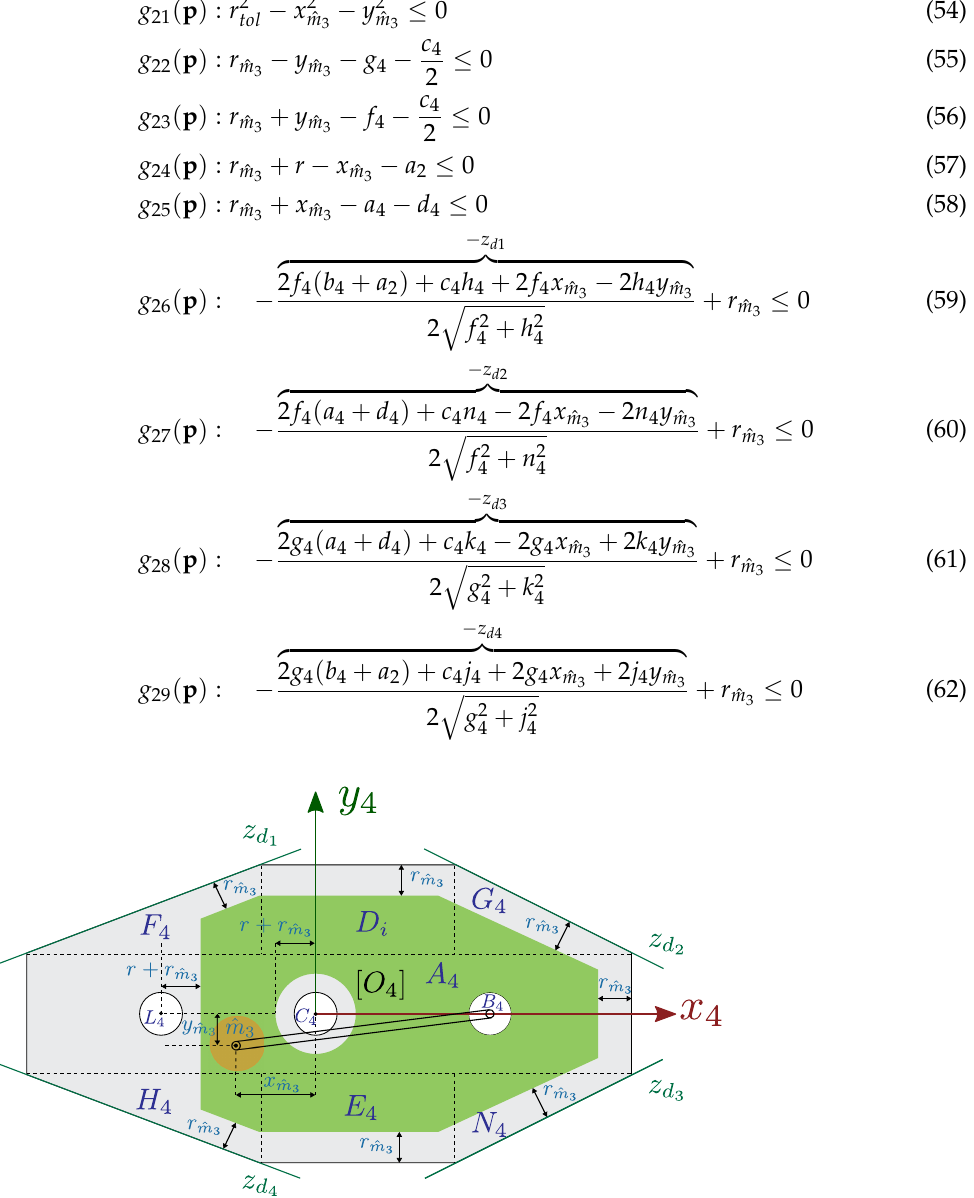
Figure 3. Graphical representation of the allowed area for placing the motor in the fourth